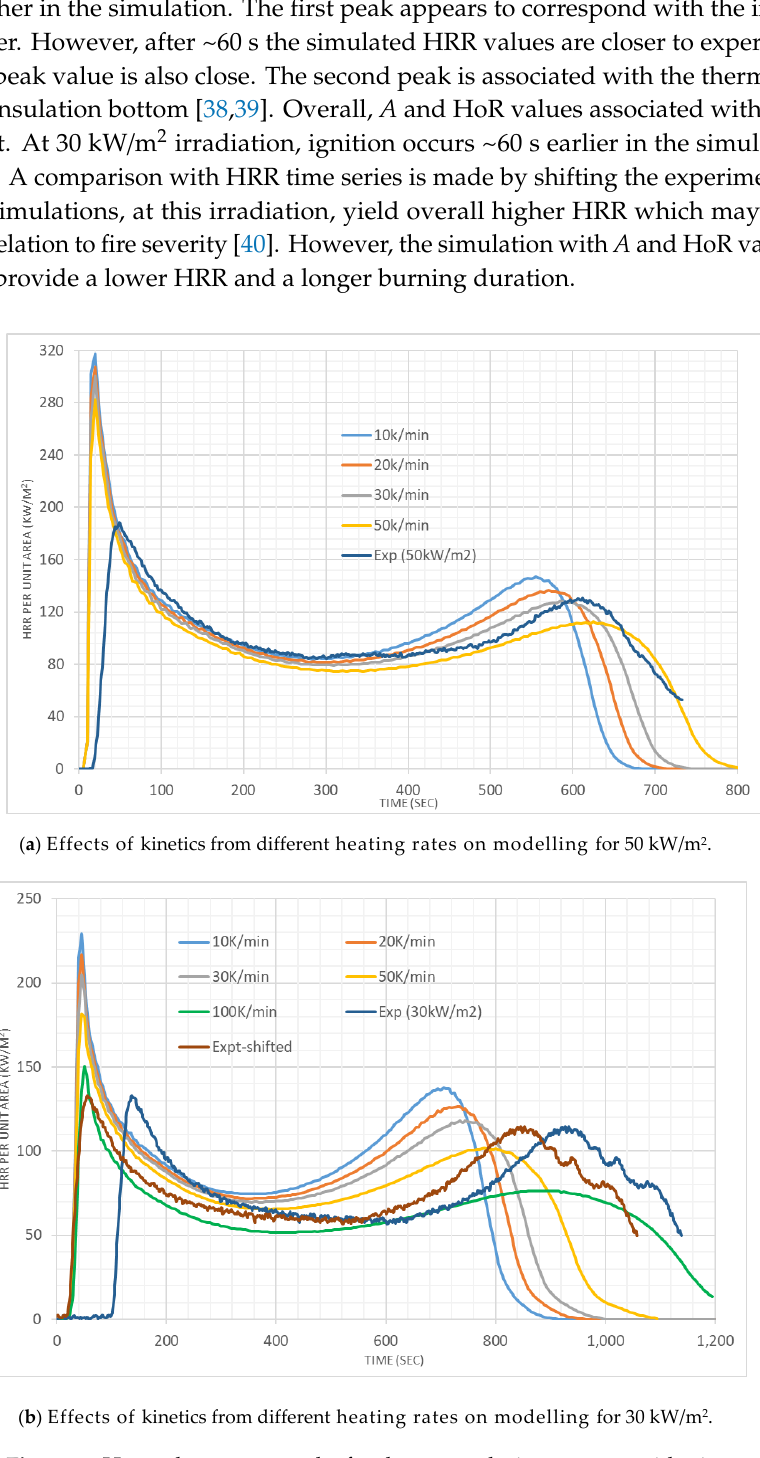
Figure 7. Heat release rate results for the cone calorimeter tests with pine.